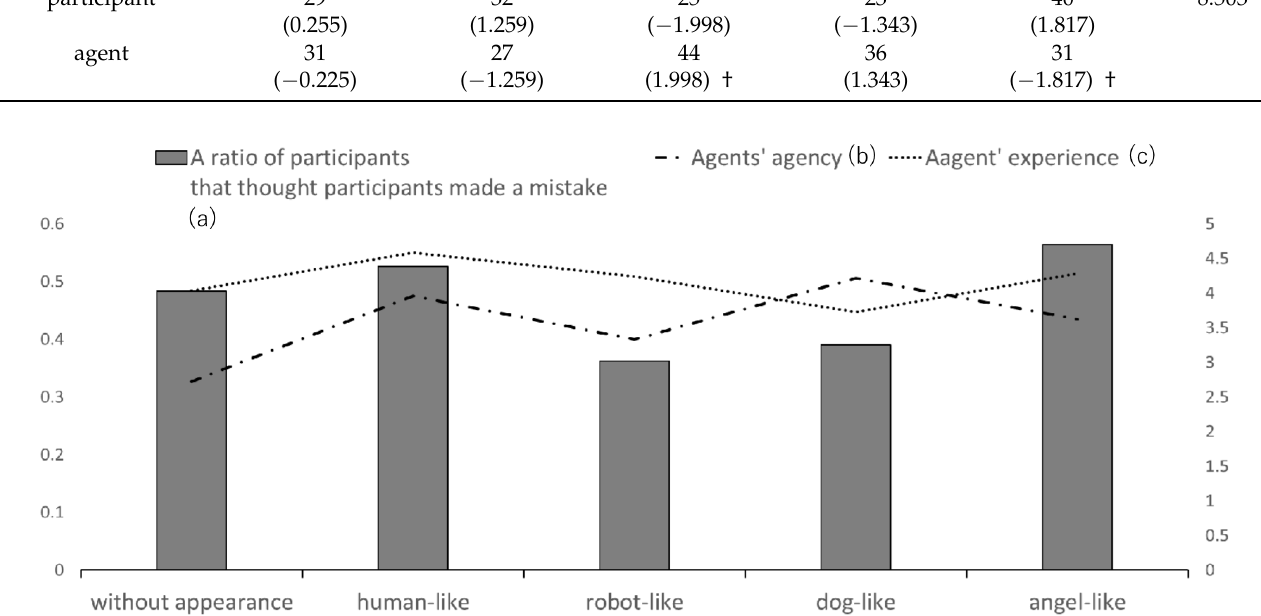
Figure 3. The graph shows (a) the ratios of the number of participants that answered that they themselves made a mistake in the game and the (b) perceived agents’ agency and (c) experience in the questionnaire survey. Left numbers are gradations for (a), and right numbers are gradations for (b) and